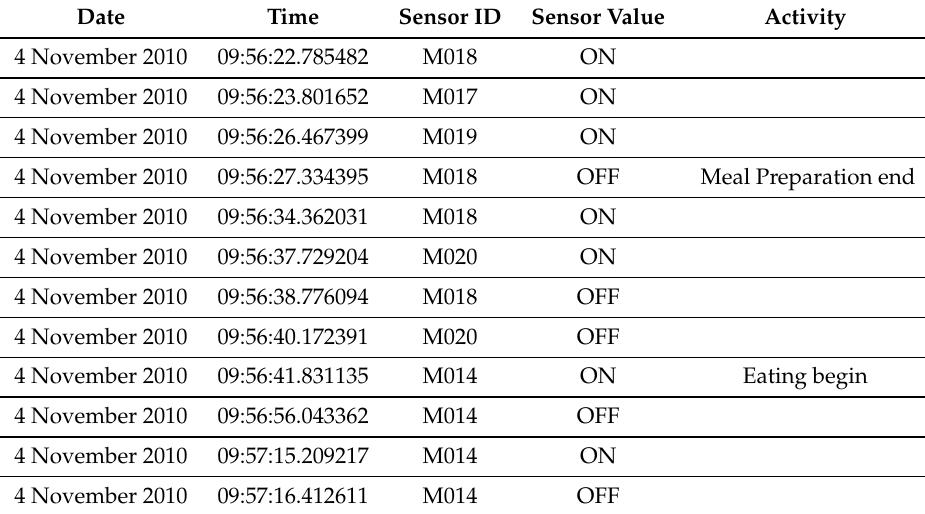
Table 3. Data extracted from the Aruba dataset [37].